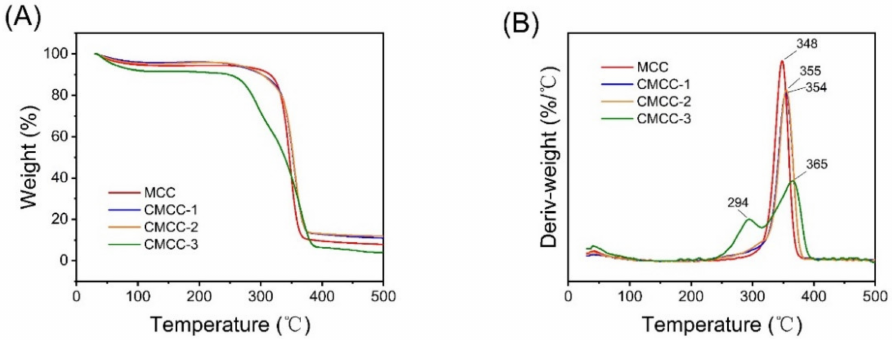
Figure 2. The TGA ( A ) and DTG ( B ) curves of MCC and